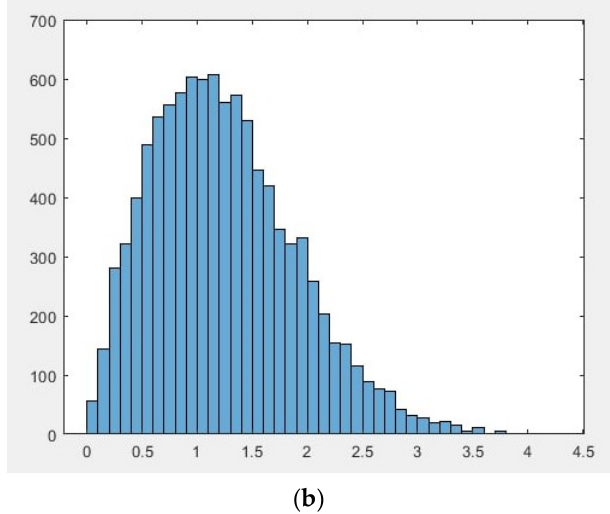
Figure 3. Generated power data for hypothesis H2: ( a ) power data for N = 1000; ( b ) histogram of observed data.